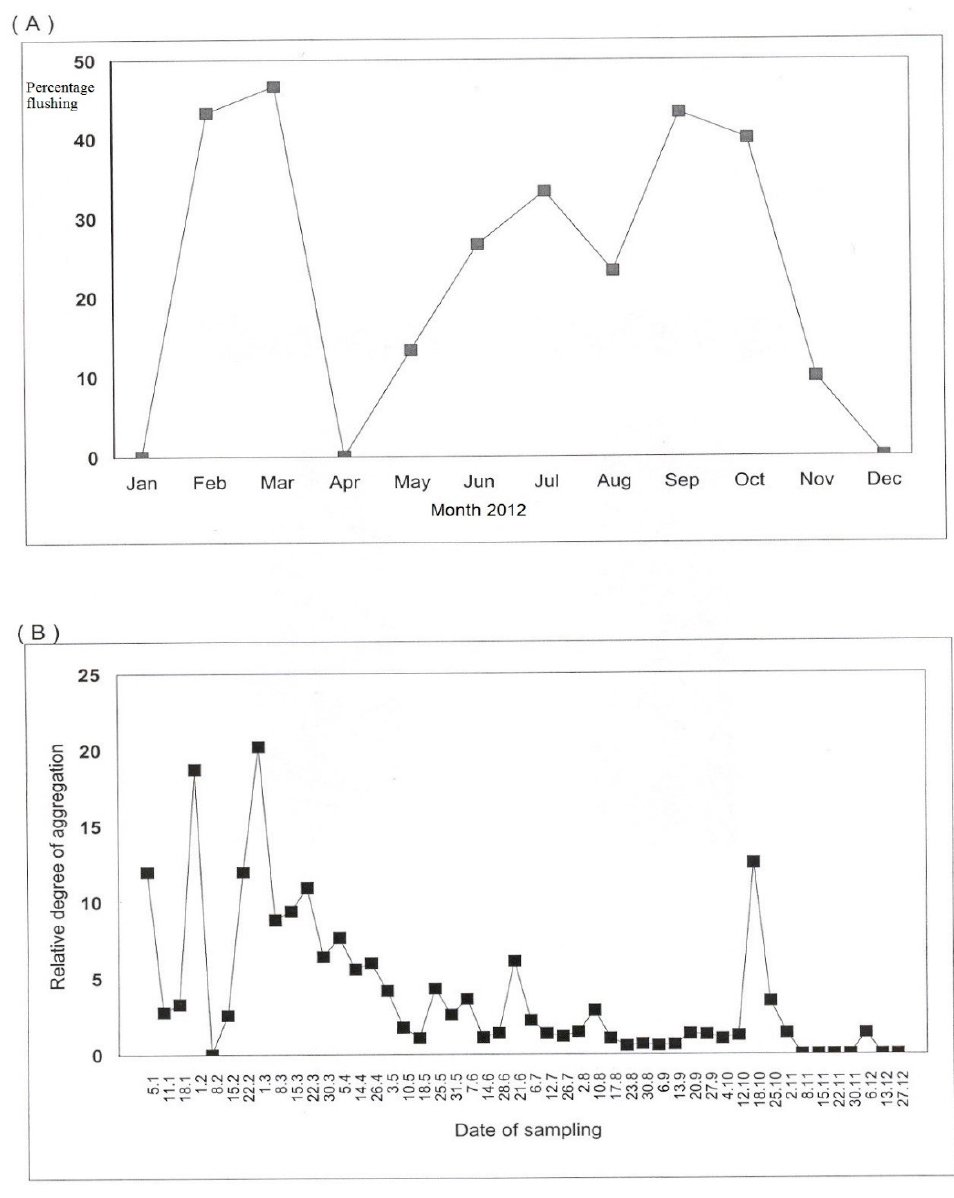
Figure 2. Percentage flushing ( A ) and relative degree of aggregation of D. citri adults ( B ) during 2012 on citrus trees.